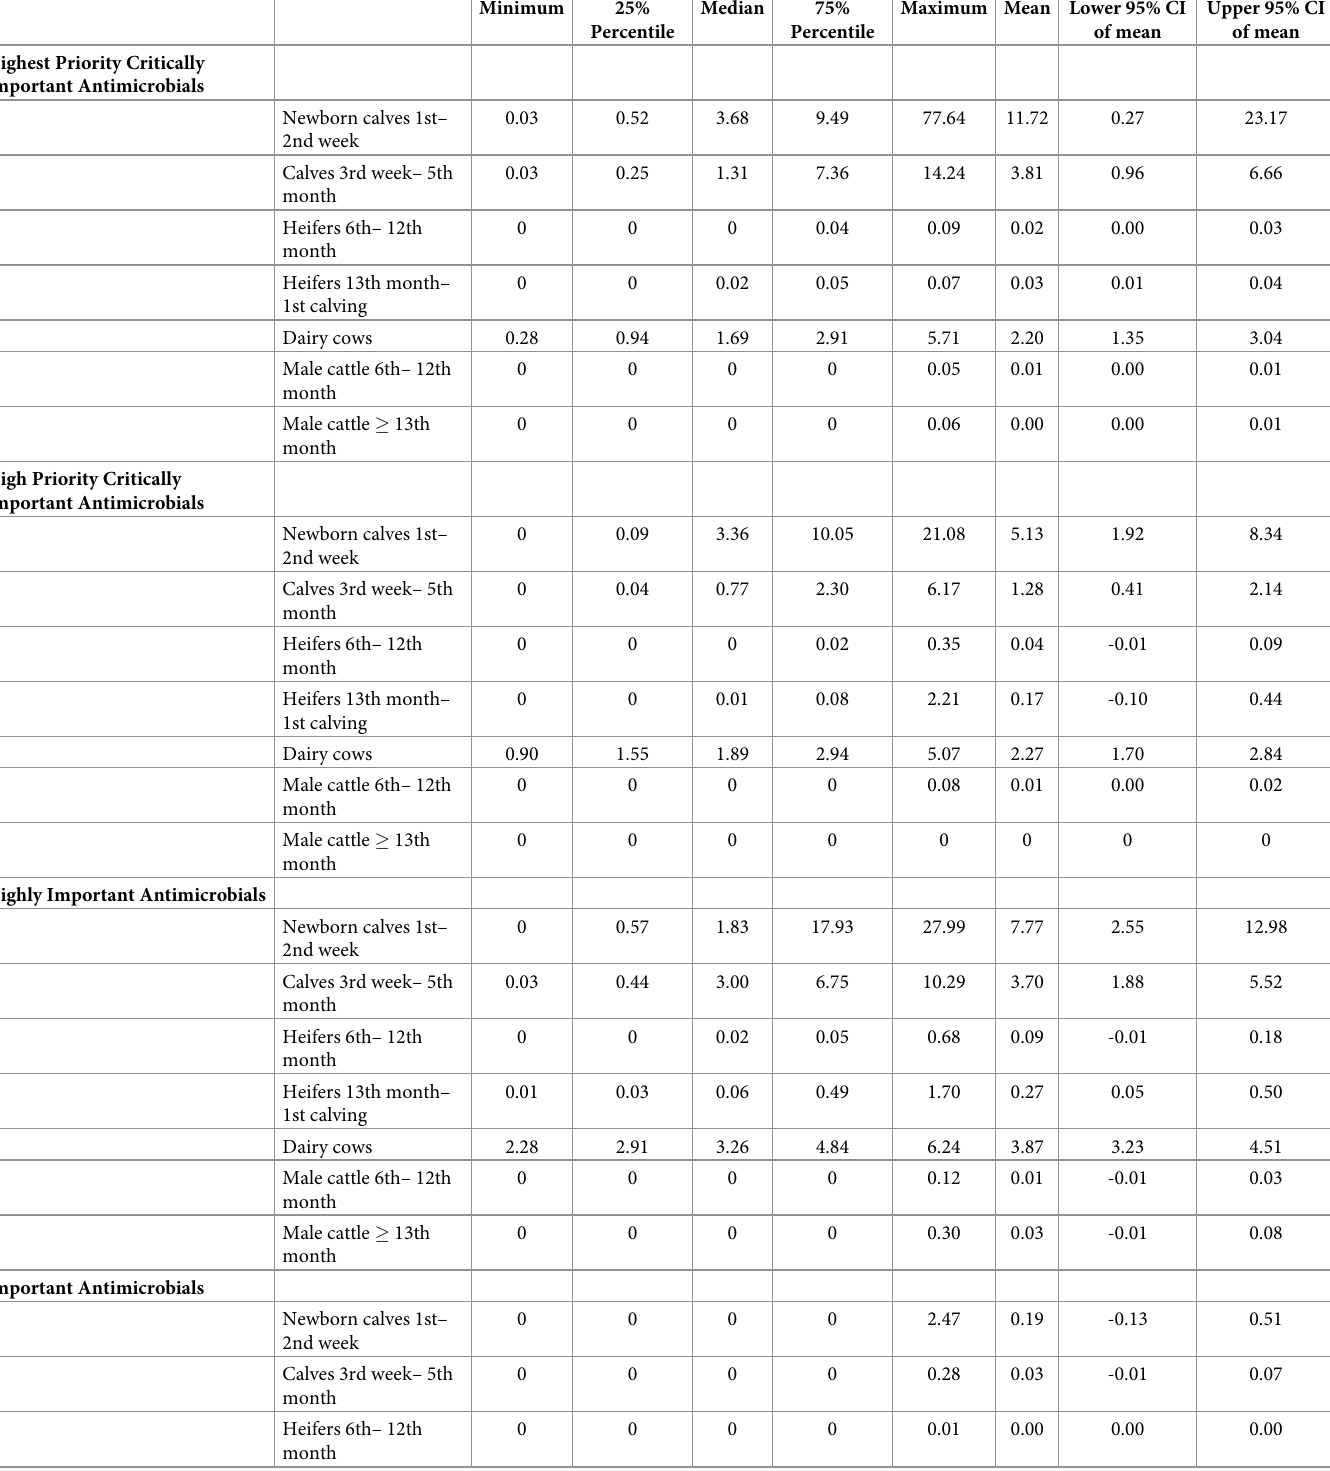
Table 4. Descriptive statistics of the treatment frequencies per year of the different age groups according the WHO